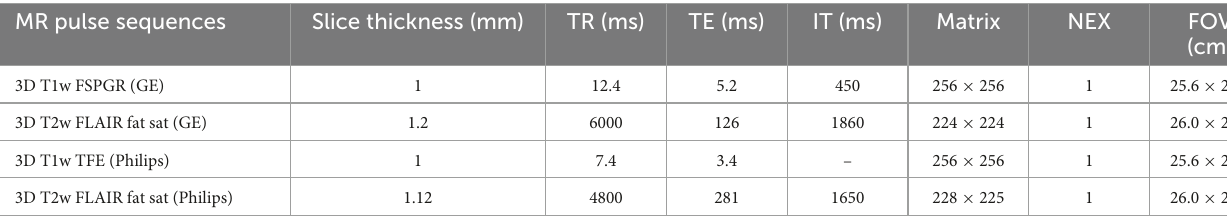
TABLE 1 MRI acquisition protocol technical details.